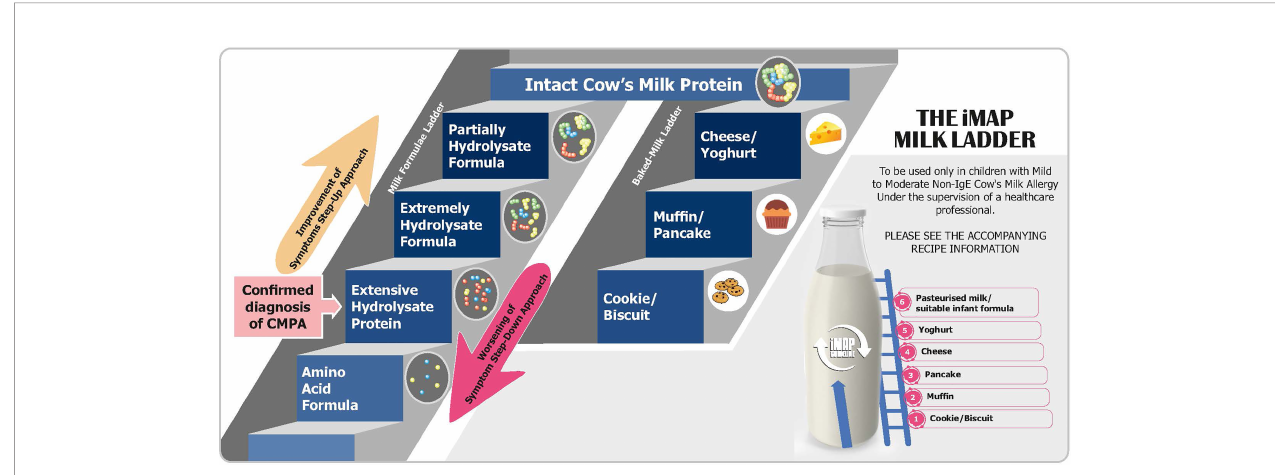
FIGURE 3 | Milk formulae and baked-milk ladder step-down and step-up to support early tolerance in management of